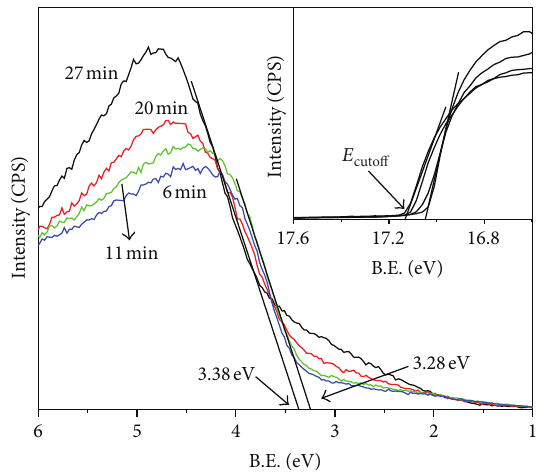
F 10: e UPS spectra of ITO/SnO